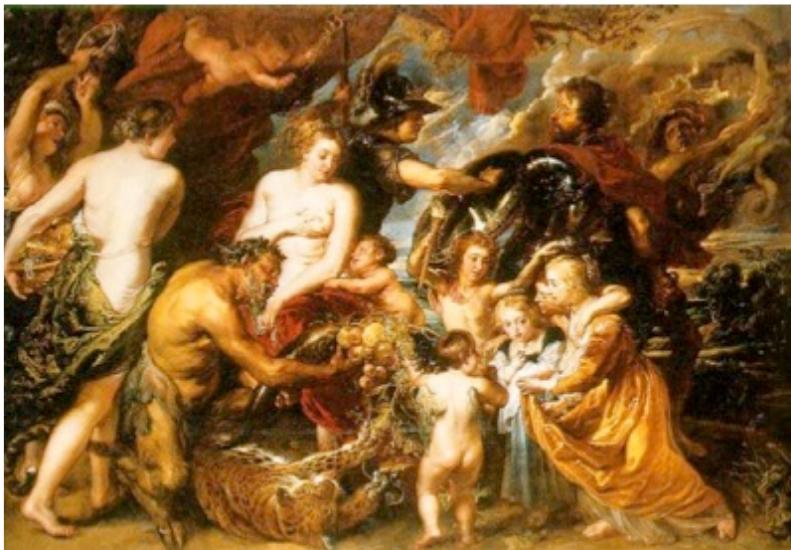
Fig. 4. Peter Paul Rubens, Allegory on the Blessings of Peace, 1629-30. Oil on canvas, 203.5 x 298 cm. National Gallery, London.